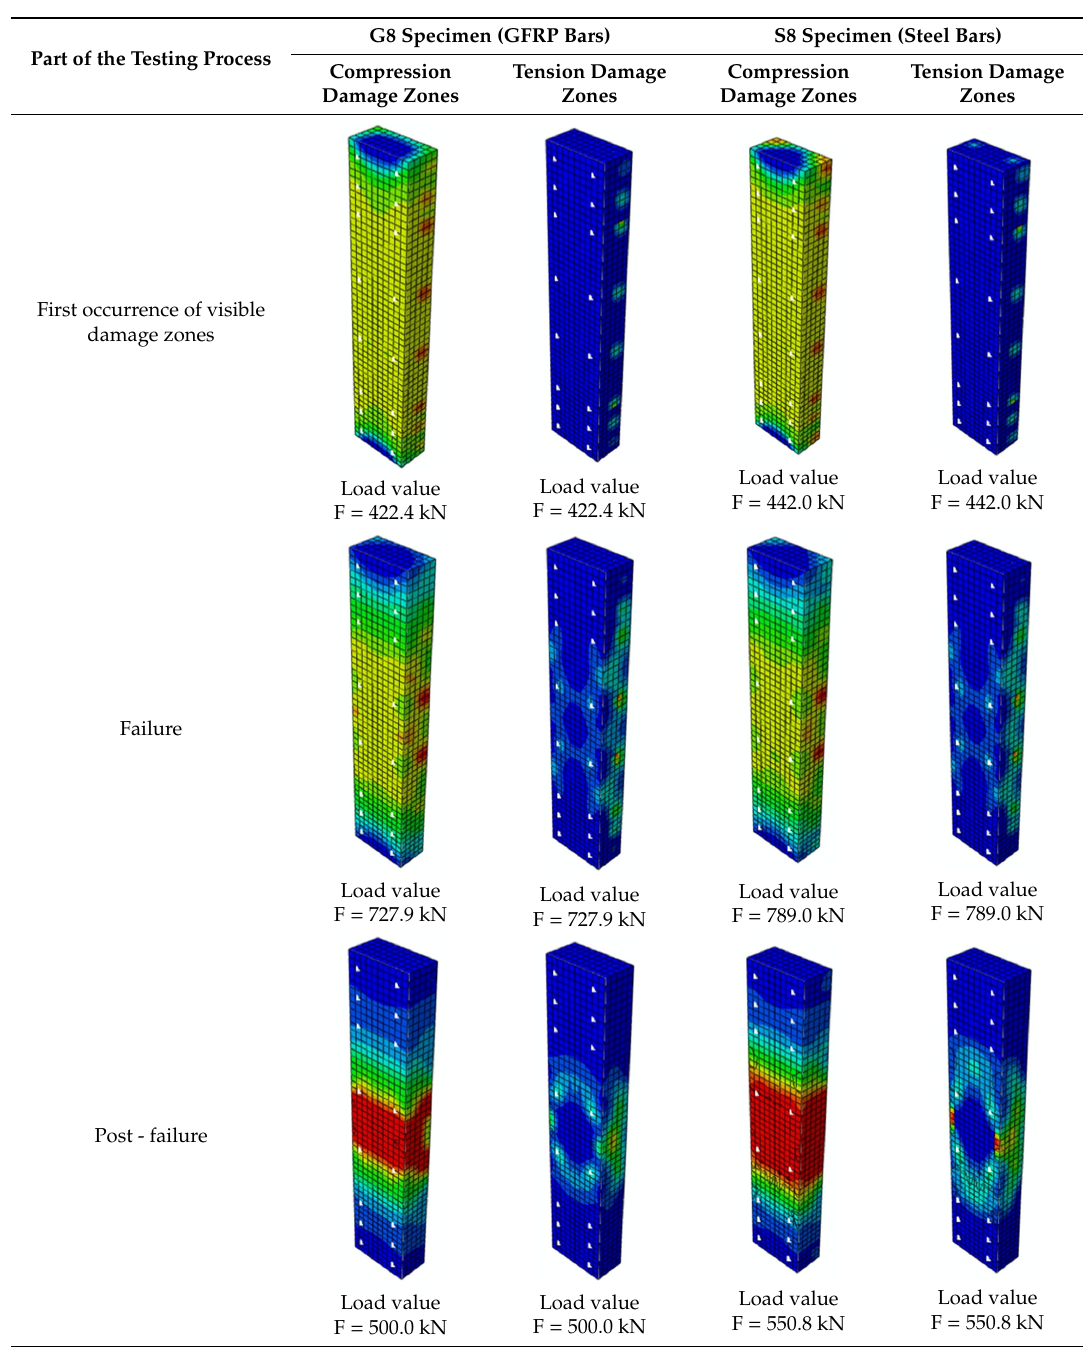
Load value F = 500.0 kN